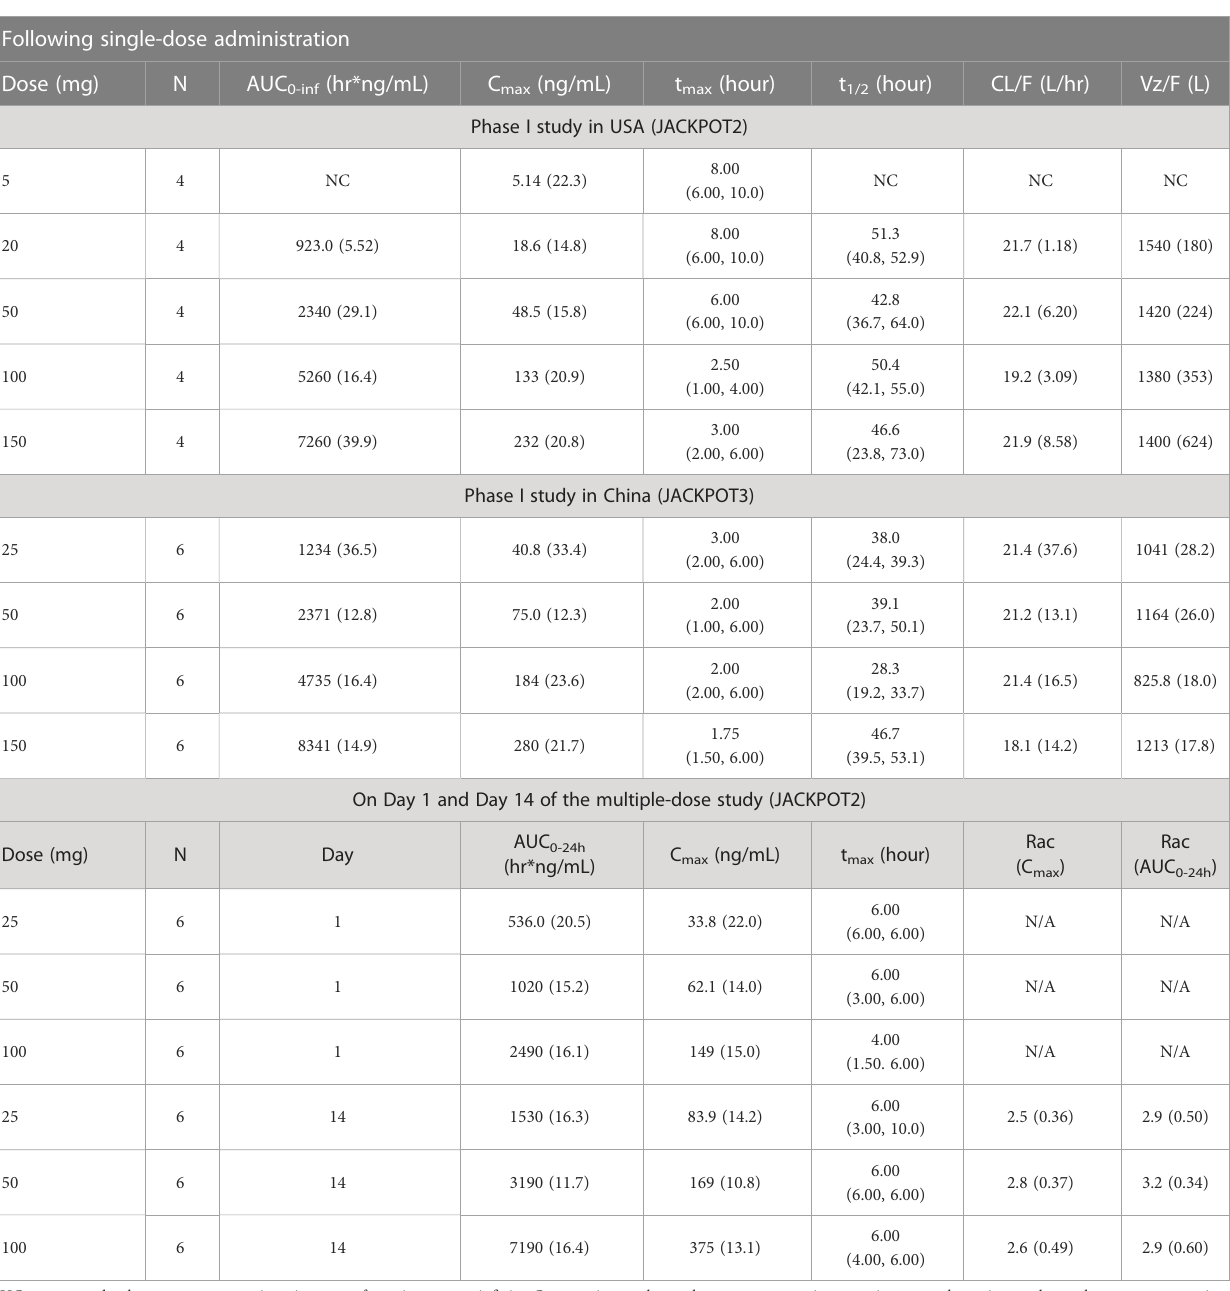
TABLE 2A Plasma PK parameters of golidocitinib following single or multiple doses. Following single-dose administration